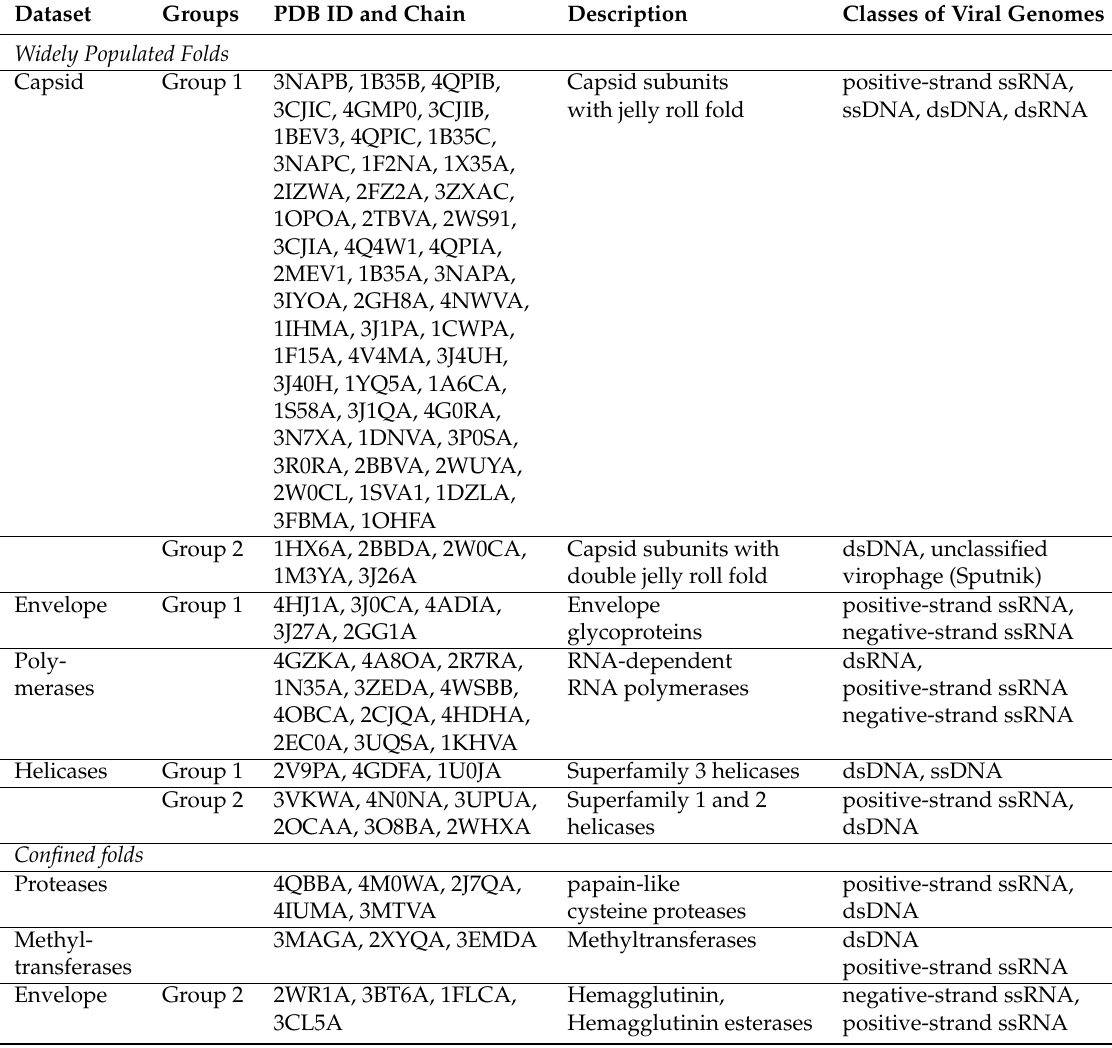
Table 2. Widely-populated and confined folds. For each dataset, clusters of similar viral structures with the respective PDB identification codes (three-character code and one-letter chain identifier) of the subunits considered are reported. For each cluster, a brief description of the biological function of the proteins is also given, as well as information about the type of genome of viruses falling in the same